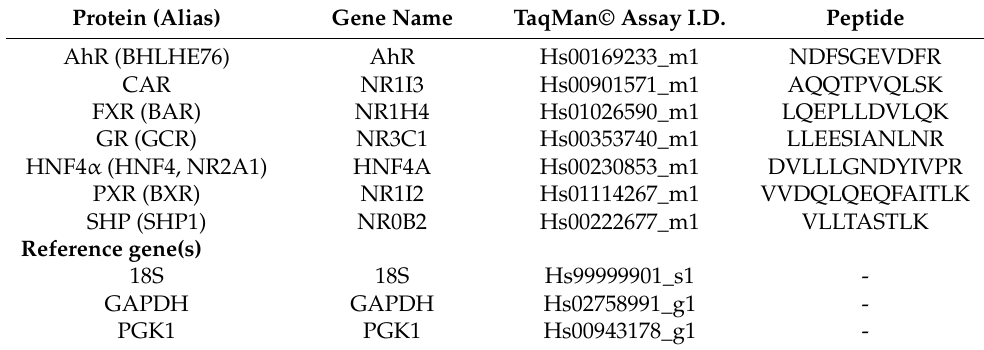
Table 4. Overview of used gene expression assays and proteospecific